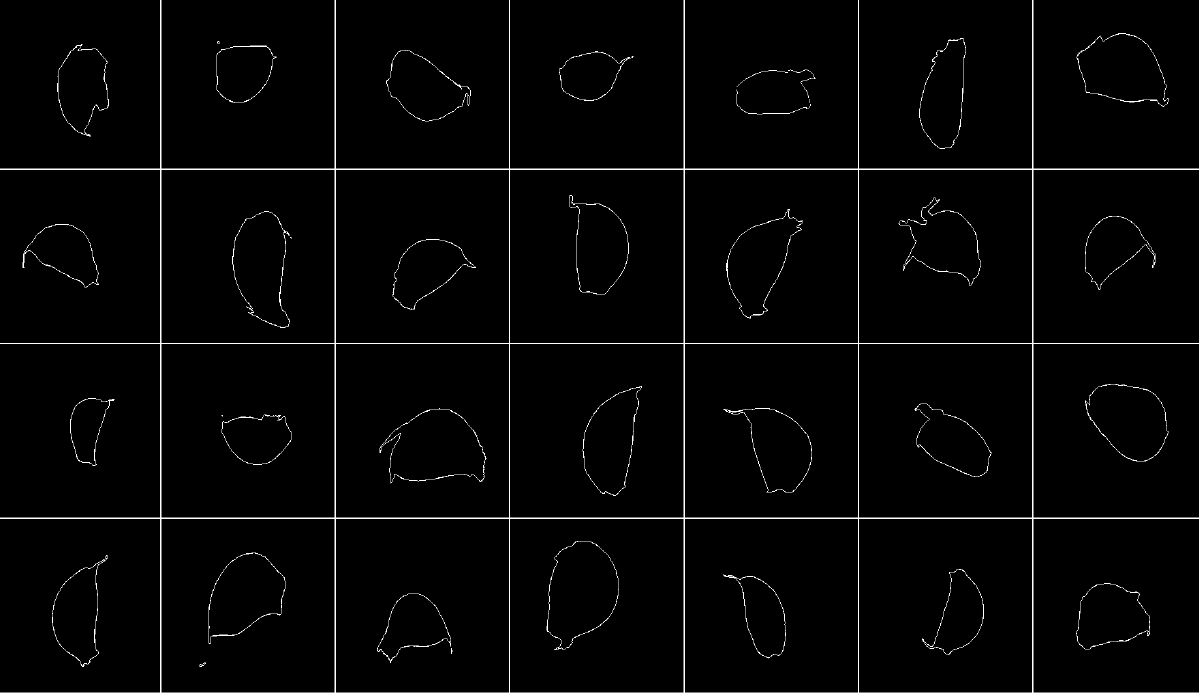
Figure 10. Final generated outer contour image samples.